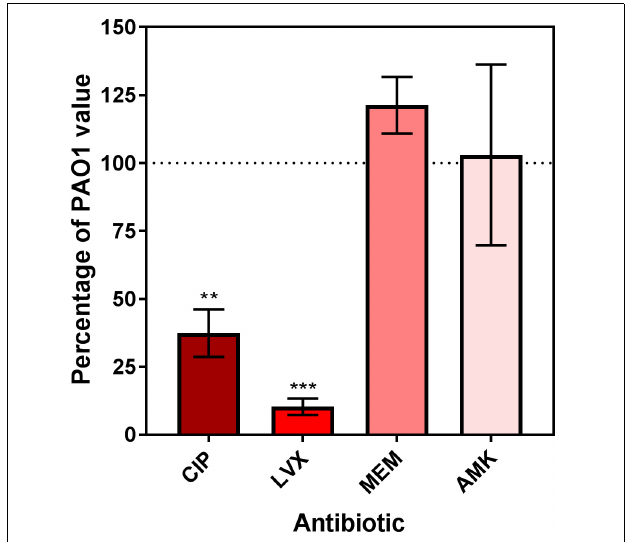
FIGURE 1 | Relative persister fraction for extracellular dnpA ::Tn expressed as percentage of the value measured for PAO1. Bacteria were exposed during 5 h to antibiotics at a concentration of 50x MIC. Persister fraction was determined as the number of cfu for bacteria exposed to the drug vs. the corresponding untreated control. The horizontal dotted line corresponds to the reference value (PAO1). Data are means ± SEM of at least 3 experiments performed in triplicates. Statistical analysis (multiple t -test) comparing dnpA ::Tn to PAO1: ∗∗ p < 0.01 and ∗∗∗ p < 0.001. CIP, ciprofloxacin; LVX, levofloxacin, MEM, meropenem, AMK,